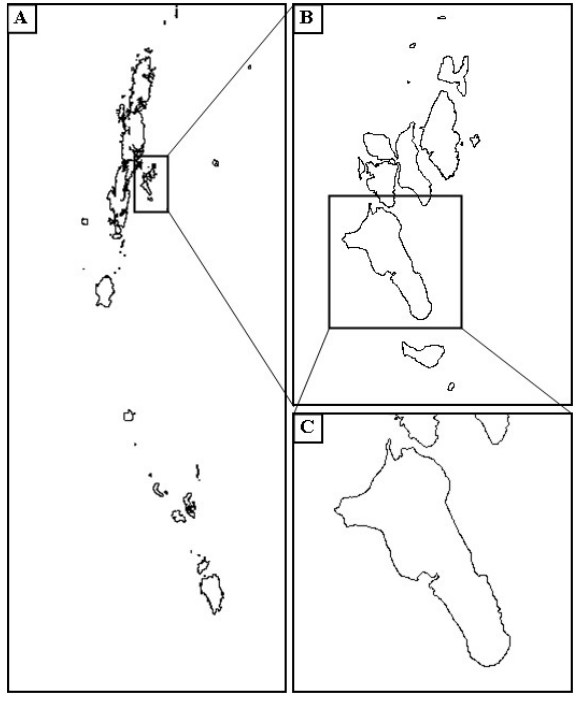
Figure 1. Map of study area. A - Andaman and Nicobar Islands; B - Ritchie’s Archipelago; C - Havelock